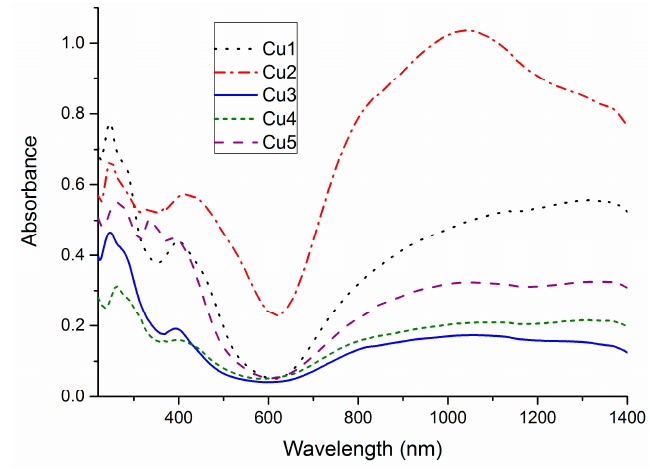
Figure 4. UV-Vis spectra in the range of 220–1400 nm for complexes Cu1–Cu5 .